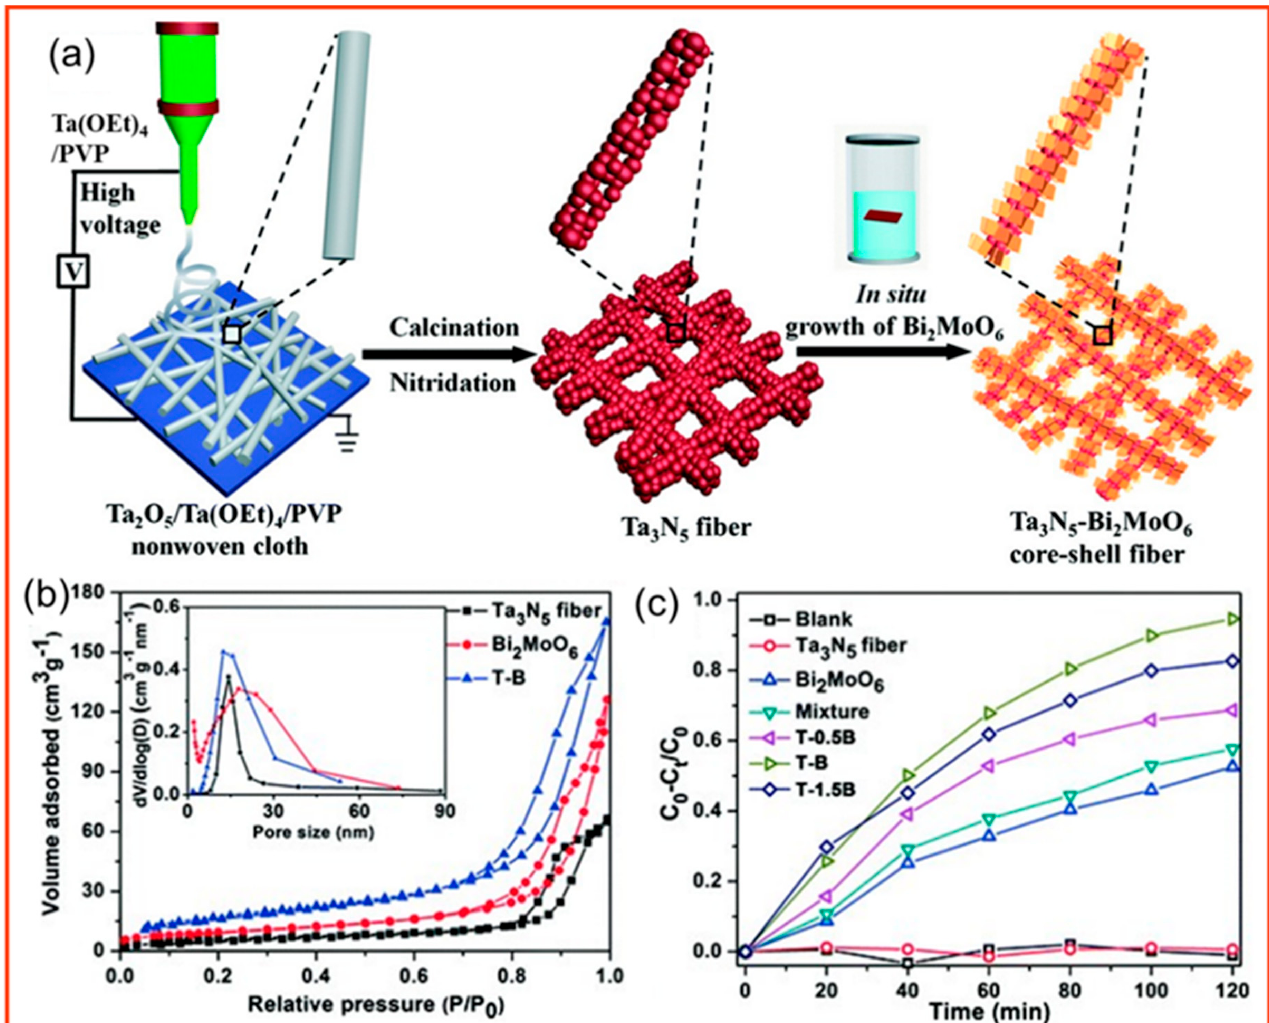
Figure 9. ( a ) Schematic of heterojunction Ta 3 N 5 /Bi 2 MoO 6 nanofiber preparation; ( b ) N 2 adsorption − desorption isotherms and pore size distribution of pure Ta 3 N 5 , Bi 2 MoO 6 and T − B (inset); ( c ) degradation efficiency of 15 mg of various photocatalysts for 4 − para − chlorophenol (4 − CP) under visible light [142].